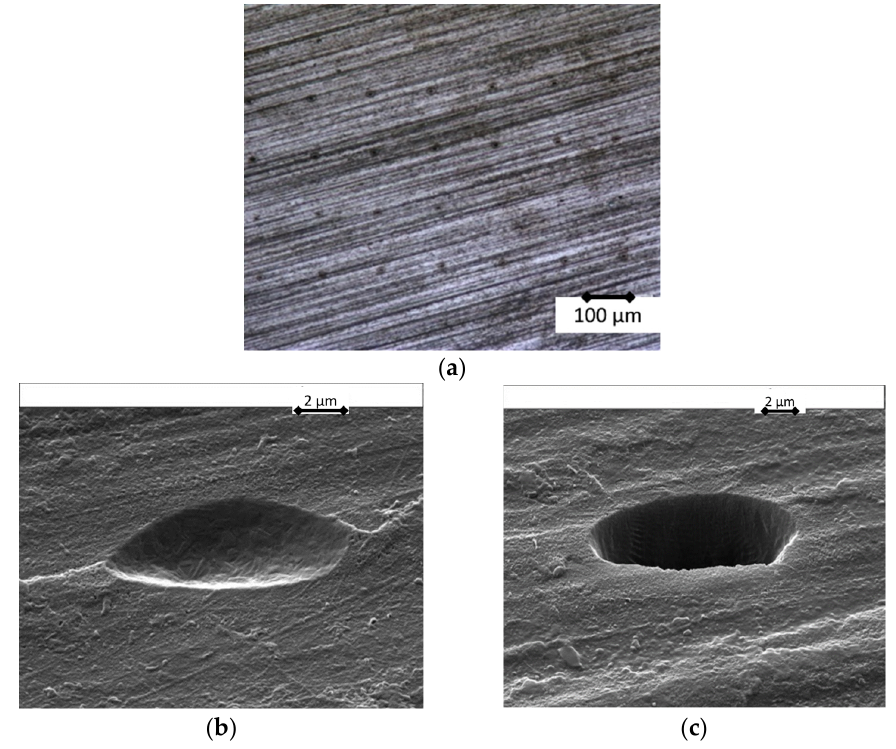
Figure 4. ( a ) Optical micrograph of the laser-modified sites on the surface of diamond, ( b ) SEM micrograph for surface modification of diamond at 10 pulses at 72 Jcm − 2 , and ( c ) SEM micrograph for surface modification of diamond at 50,000 pulses at 72 Jcm − 2 .